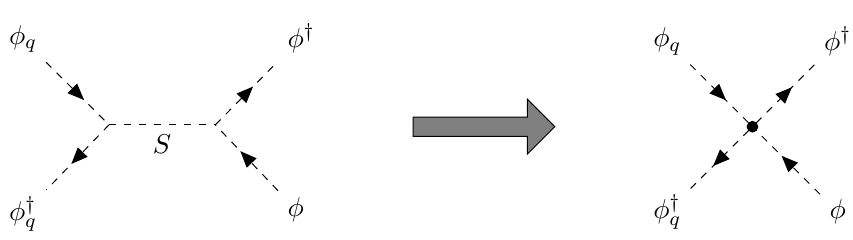
Figure 2 . Pair production φ q φ † → φφ † through the s -channel exchange of a heavy singlet scalar q S . The EFT description can be obtained by expanding and truncating the s -channel propagator, yielding a series of local